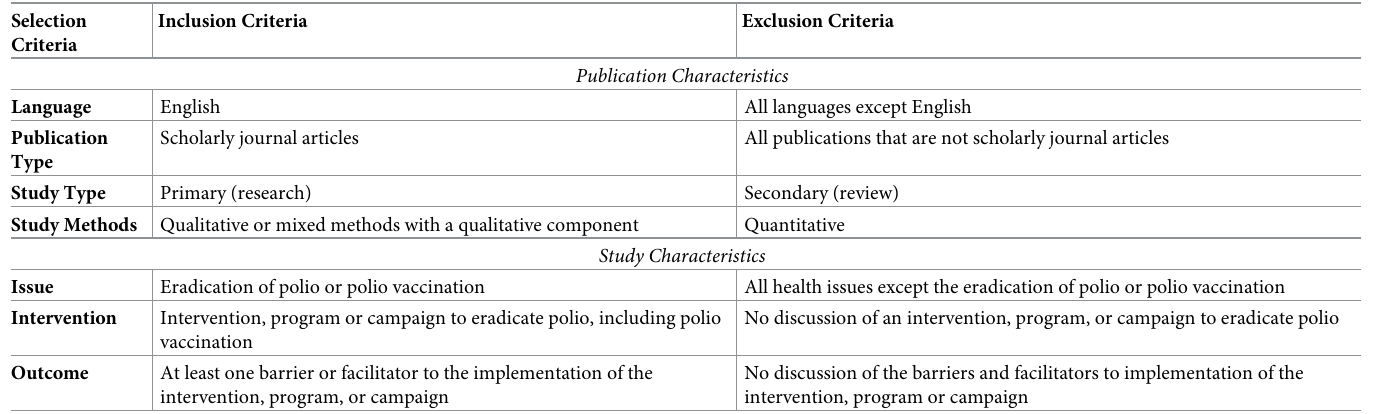
Table 1. Summary of inclusion and exclusion